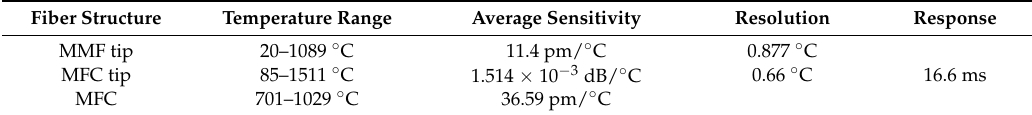
Figure 25. Schematic diagram of experimental setup for humidity sensing of MFC based humidity sensor.